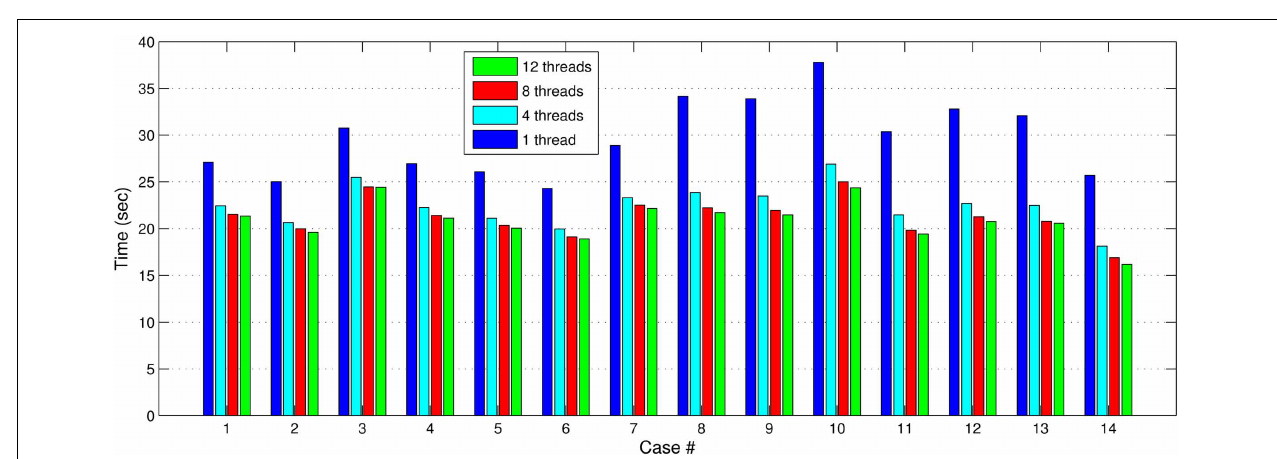
FIGURE 7 | The PBNRR total execution time for the 14 clinical cases using 1, 4, 8, and 12 hardware